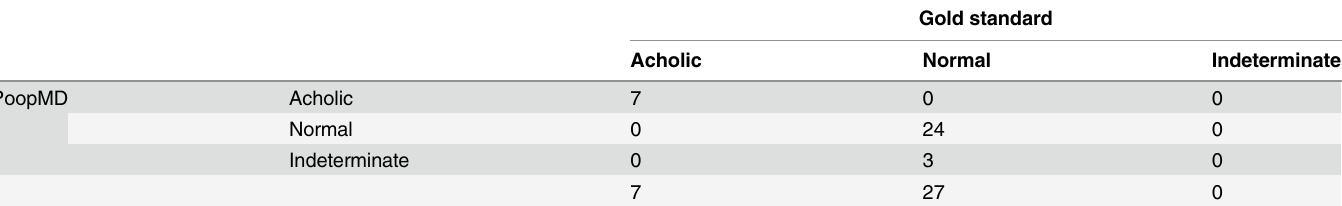
Table 1. Accuracy of